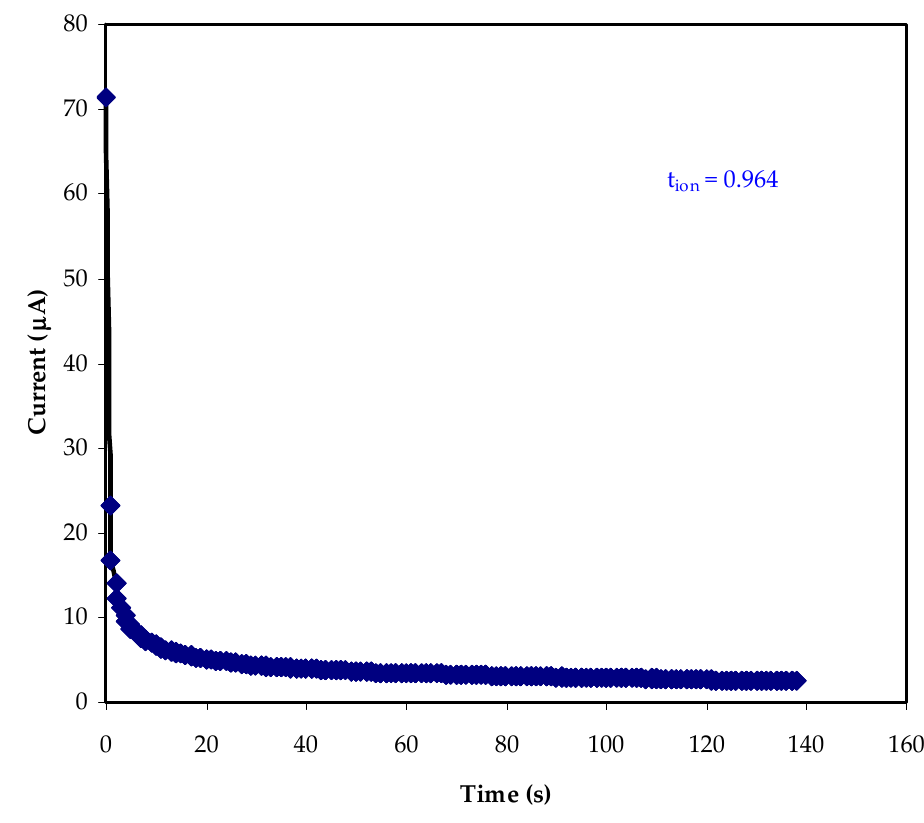
Figure 5. The polarization current against time for the MC-KI-glycerol film with the highest conductivity.